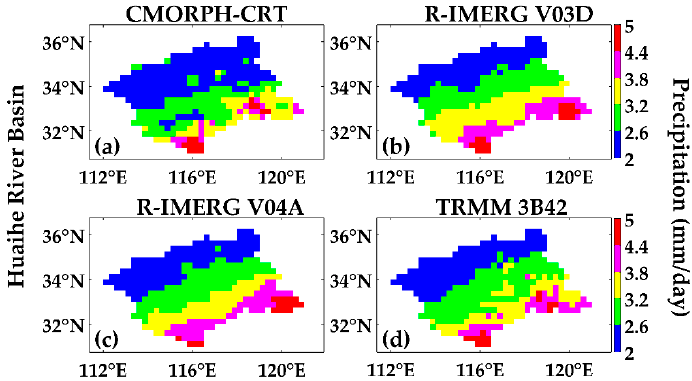
Figure 7. Spatial distribution of daily average precipitation (mm/day) at 0.25° resolution between 1 June 2014 and 30 November 2015 derived from CMORPH-CRT ( a ); R-IMERG V03D ( b ); R-IMERG V04A ( c ); and TRMM 3B42 ( d ) over the Huaihe River Basin.